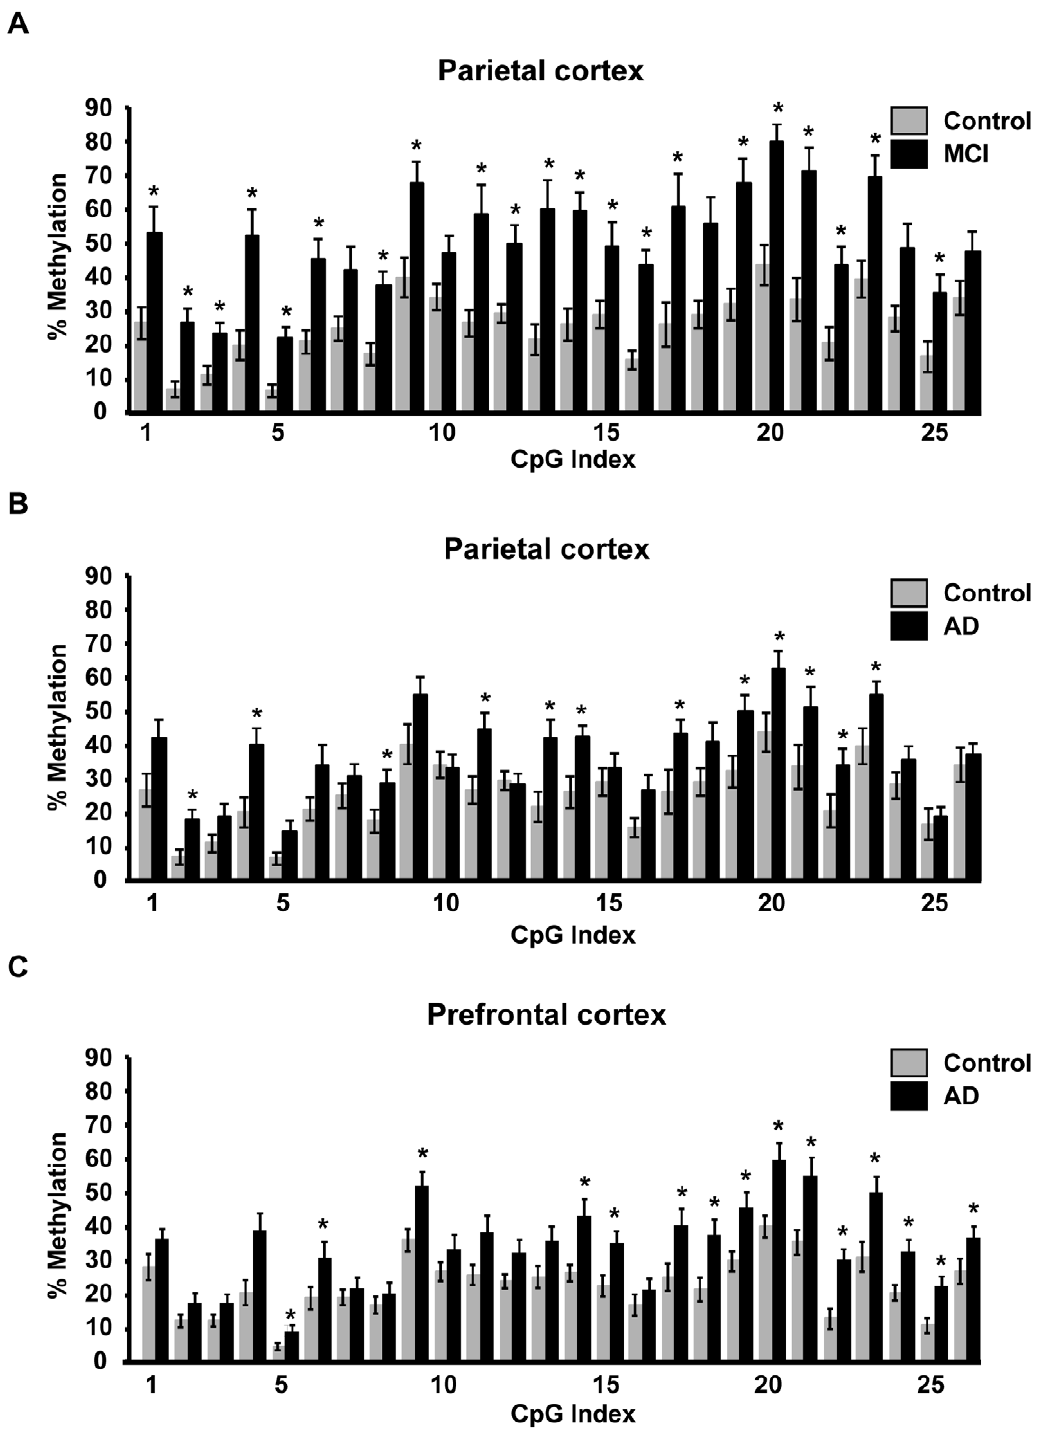
Figure 3. Effects of MCI and AD on distribution of mCpGs across the rDNA promoter. Percent CpG methylation at each of 26 individual CpG sites located in the rDNA promoter in samples from parietal- ( A–B ) and prefrontal cortex ( C ). For the purpose of clarity, parietal cortex data for MCI and AD groups are presented on separate graphs. The controls are the same in both cases. Data are means 6 SEM for each analyzed group of cases (n as in Fig. 1); *, p , 0.05 (SAM statistics as compared to controls).